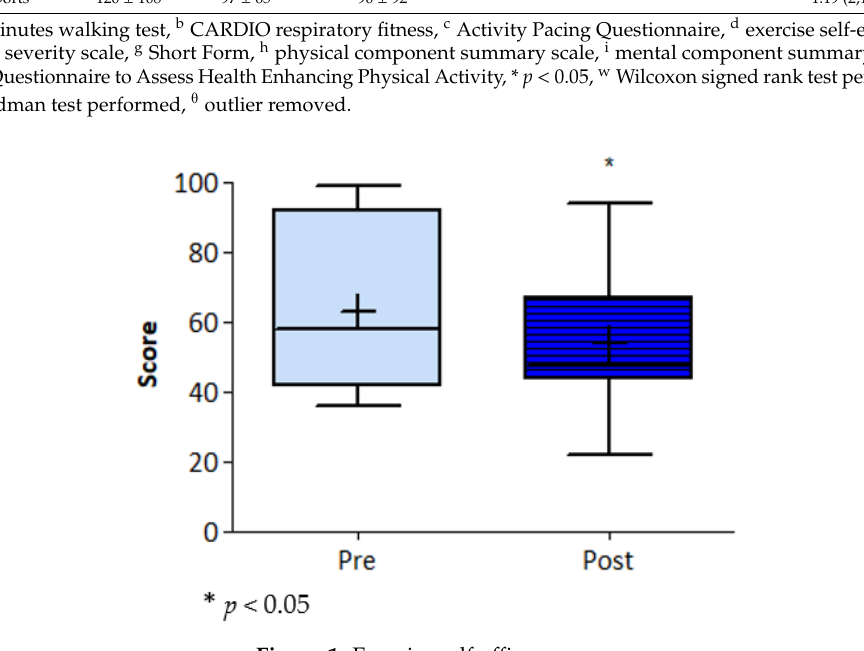
Table 3. Two weeks' adherence to the walking and exercise programs.